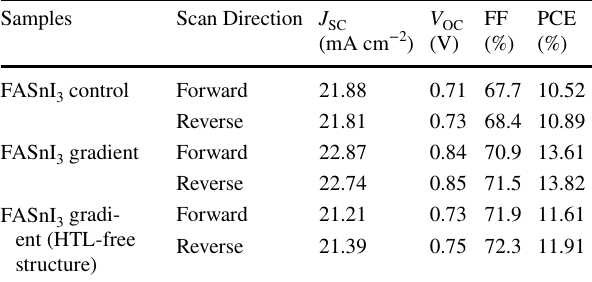
Table 1 The PV parameters of the FASnI 3 control, FASnI 3 gradient, FASnI 3 with the surface passivation of PMMA, as well as the HTL- free FASnI 3 gradient